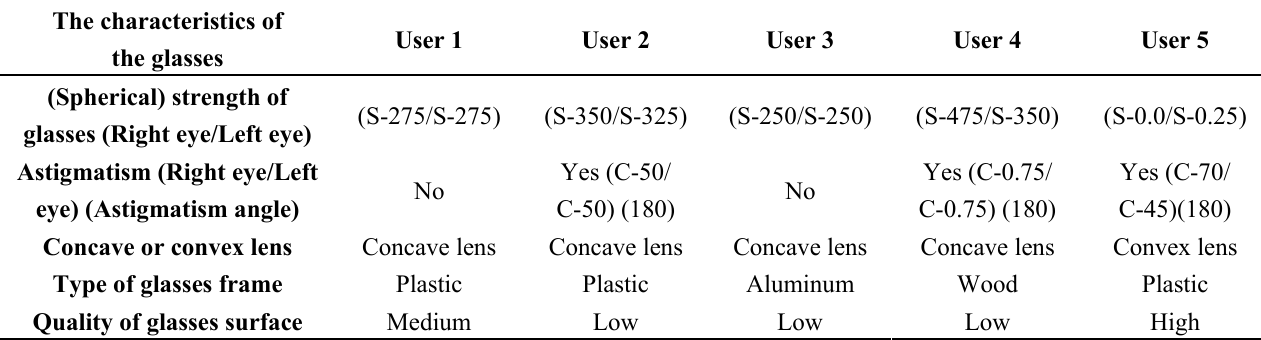
Table 1. The characteristics of the glasses for users 1–5 from Tables 1, 2, 4, 6, 8 and